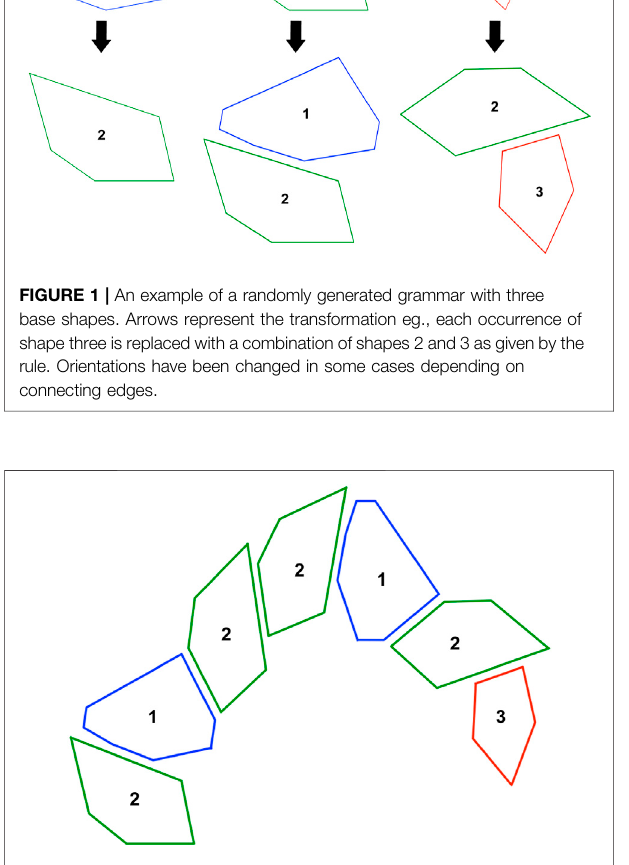
FIGURE 2 | The resulting outcome from using the Grammar in Figure 1 and a starting point (axiom) (cid:2) 2 with three iterations. Each shape is connected to the next one using a fi xed joint or revolute joint.